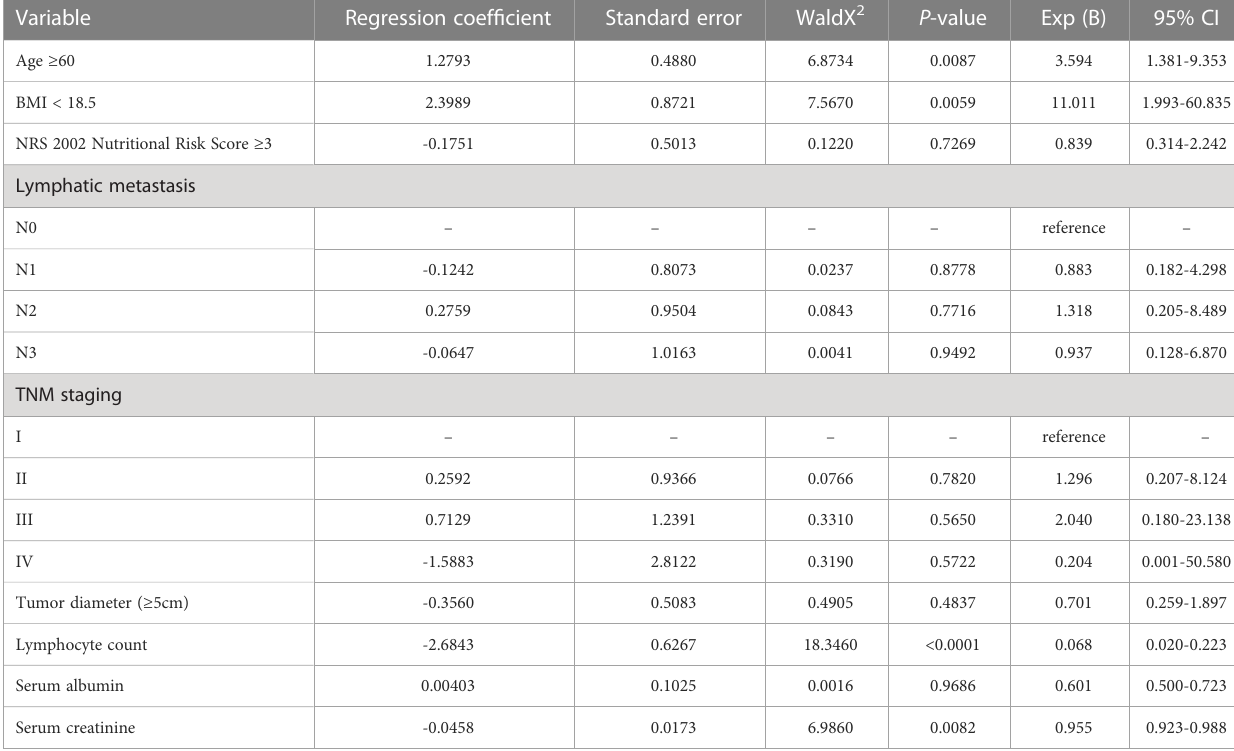
TABLE 3 PNIS multivariate